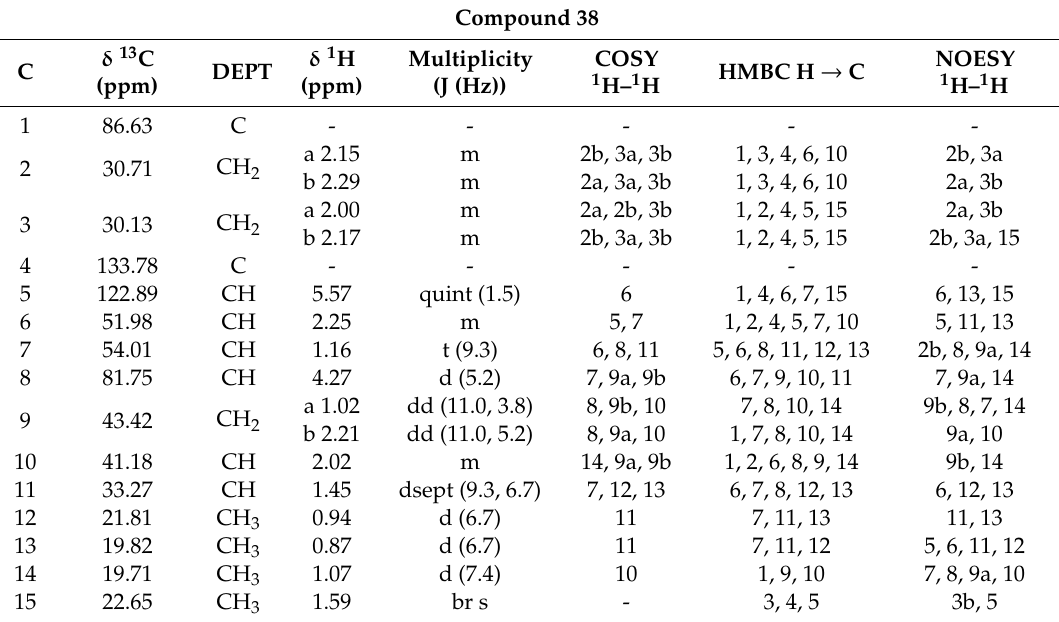
Table 1. NMR data of compound 38